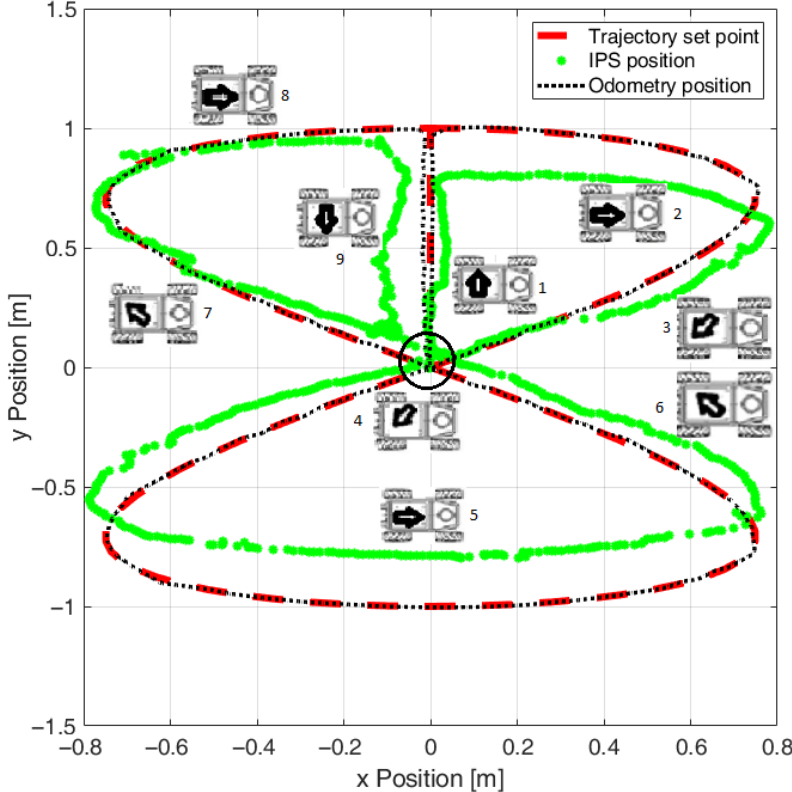
Figure 5. Initial experiments without odometry calibration (the numbered icons indicate the direction and the order of travel on the trajectory